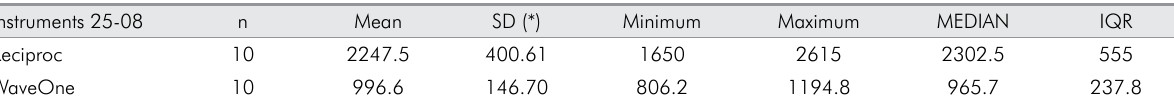
Table 3. Statistical descriptions of the NCFs observed for the instruments in the dynamic test